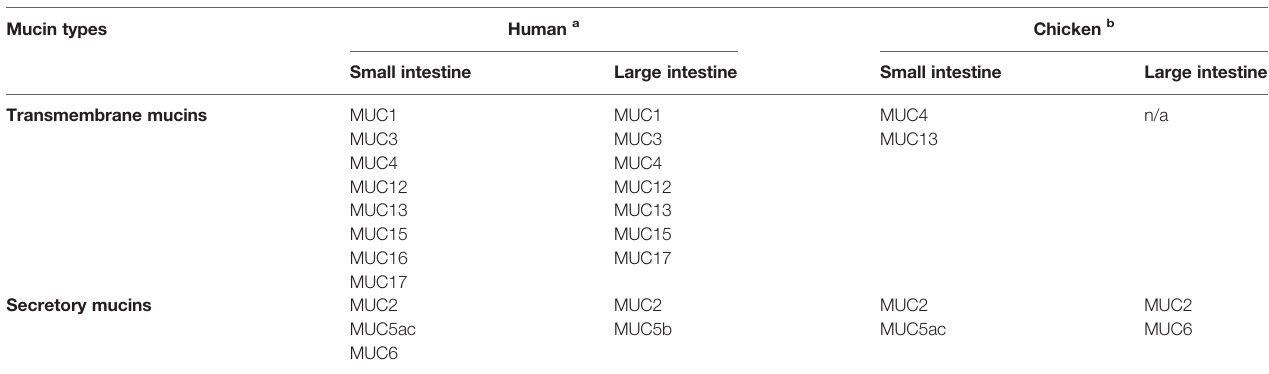
TABLE 2 | Mucin genes expressed in the small and large intestine of human and